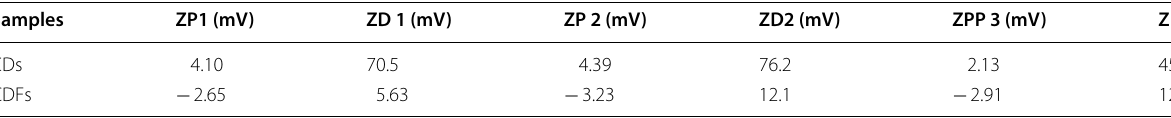
Table 1 Zeta potential (ZP) and Zeta deviation (ZD) of CDs and CDFs